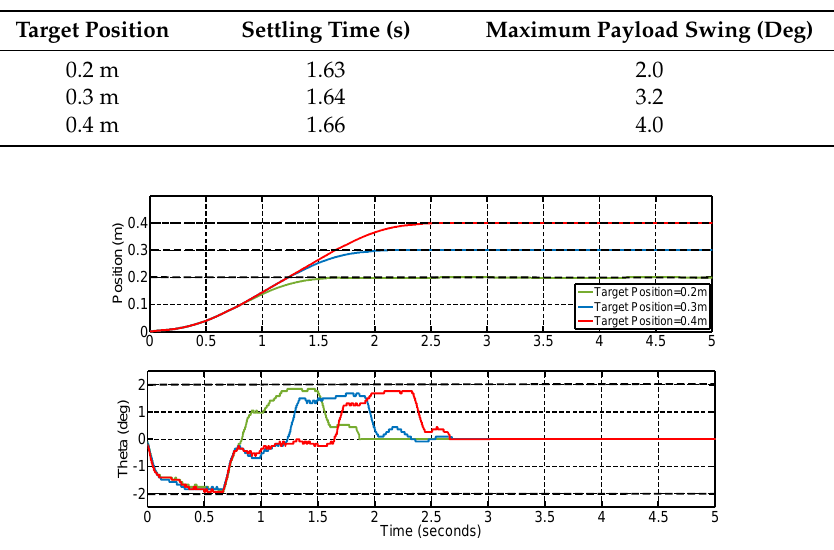
Figure 11. The response within an angle constraint scheme. Table 5. Performance within angle constraint.